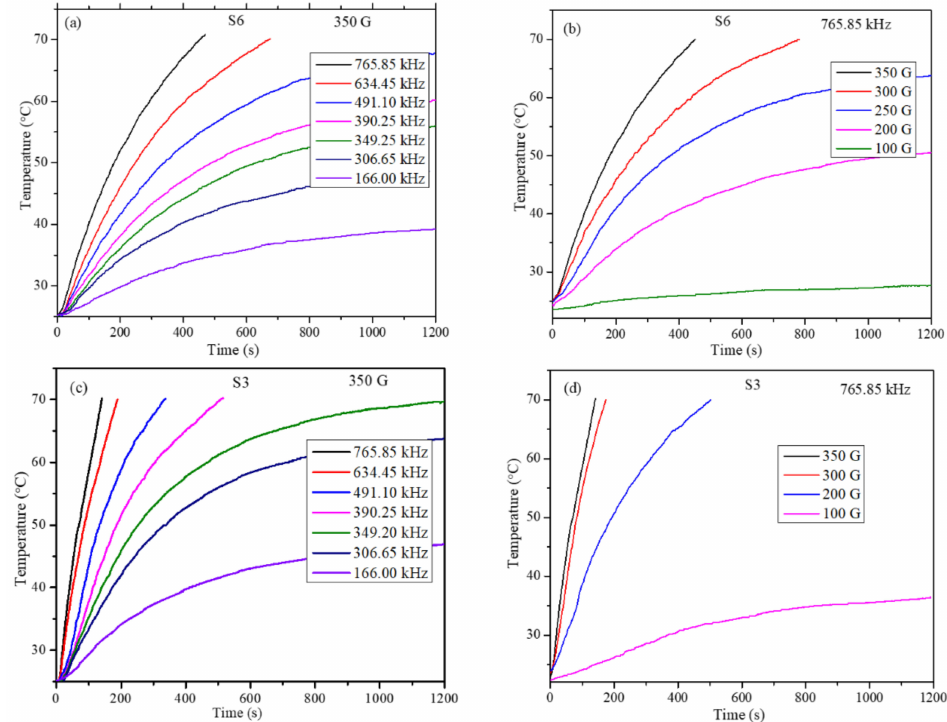
Figure 5. Heating profiles of concentration 10 mg/ml ( a ) for S6 samples at fixed field strength 350 G, ( b ) for S6 samples at fixed AC frequency 765.85 kHz, ( c ) for S3 samples at fixed field strength 350 G, and ( d ) for S3 samples at fixed AC frequency 765.85